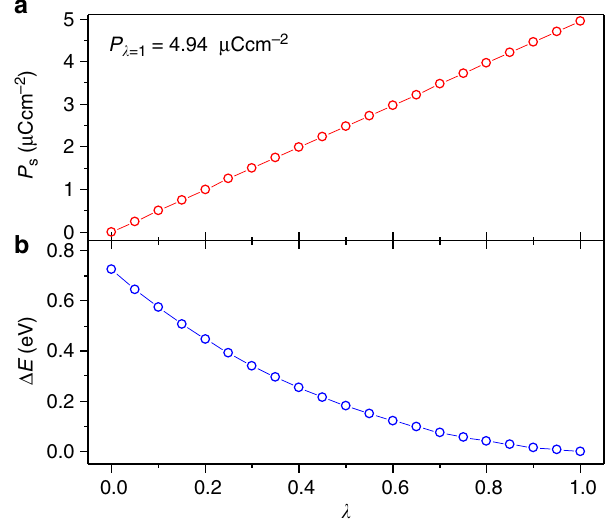
Figure 9 | Results from the first-principles density-functional theory of 1. ( a ) The variation of ferroelectric polarization along the path from the centric ( l ¼ 0) to the ferroelectric structure ( l ¼ 1). ( b ) The variation of the total energy in each unit cell along the path from the centric ( l ¼ 0) to the ferroelectric structure ( l ¼ 1). The dimensionless parameter l is the normalized amplitude of the atomic distortion connecting the structure of the PP and the structure of the